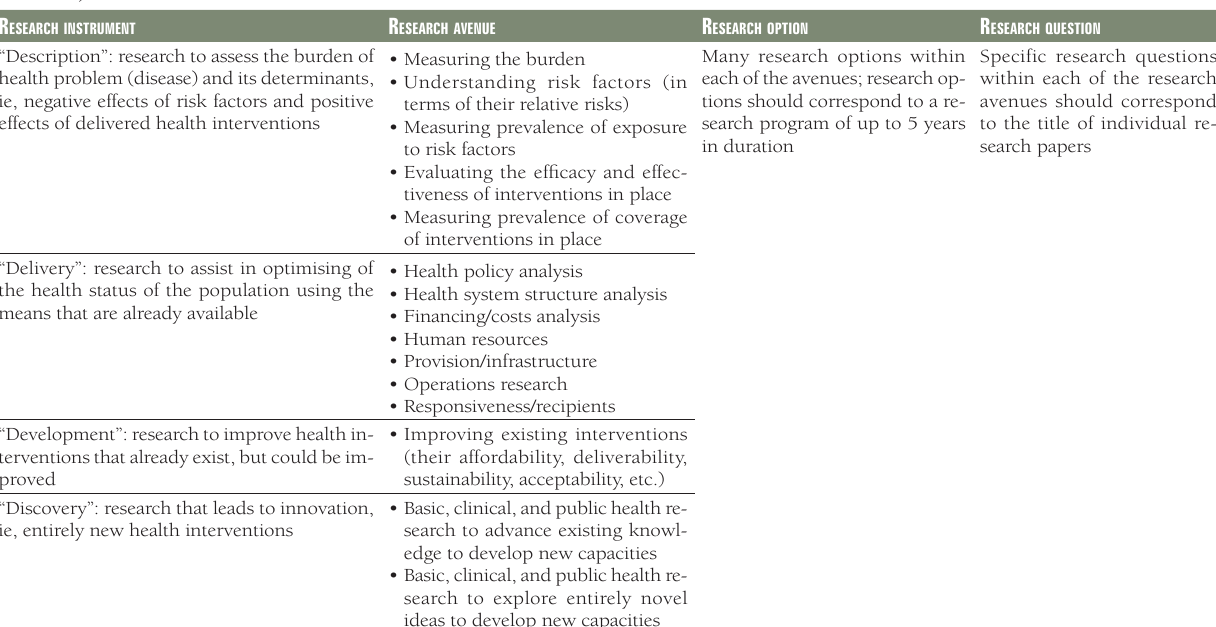
Table 2. Child Health and Nutrition Research Initiative’s (CHNRI) proposed framework for systematic listing of research ideas in health research, which takes into account the “instruments” of health research (rows) and the “depth” of proposed research ideas